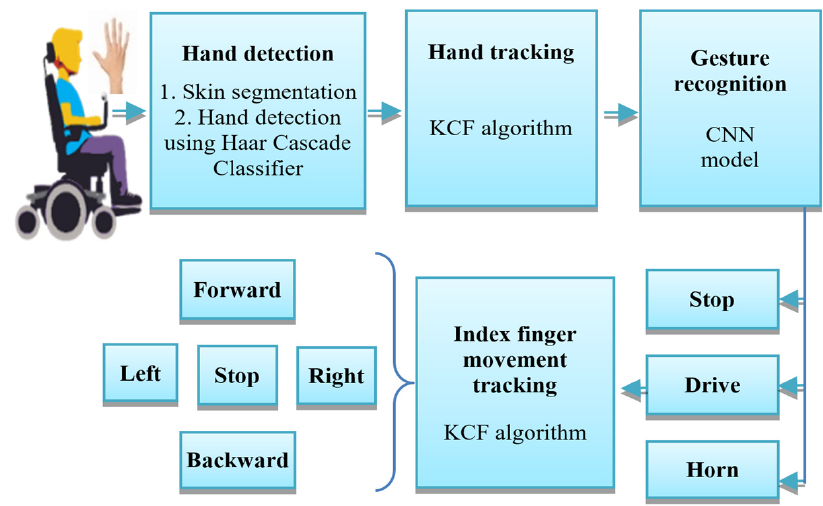
Figure 2. The overall scenario of the gesture recognition process.